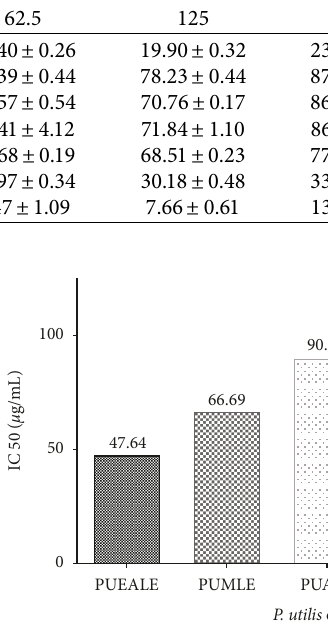
Table 4: DPPH free radical scavenging capacity of P. utilis leaf and seed extract obtained from different solvents at various concentrations. Concentration ( μ g/mL)